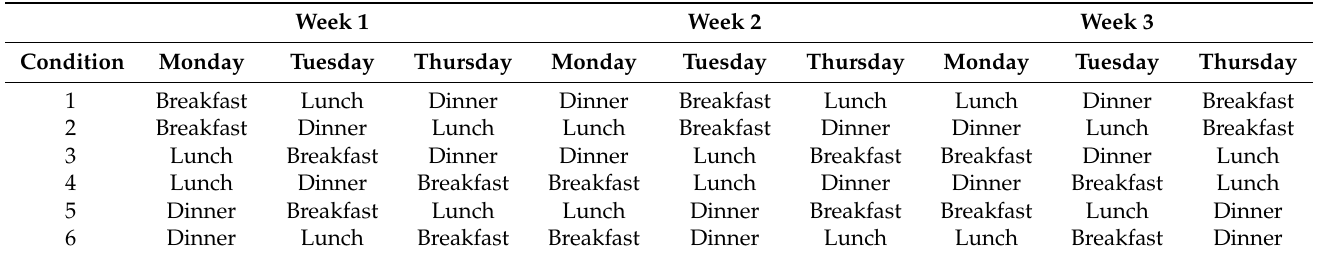
Table 1. The order of mealtimes assigned to the 6 conditions using a Latin Square